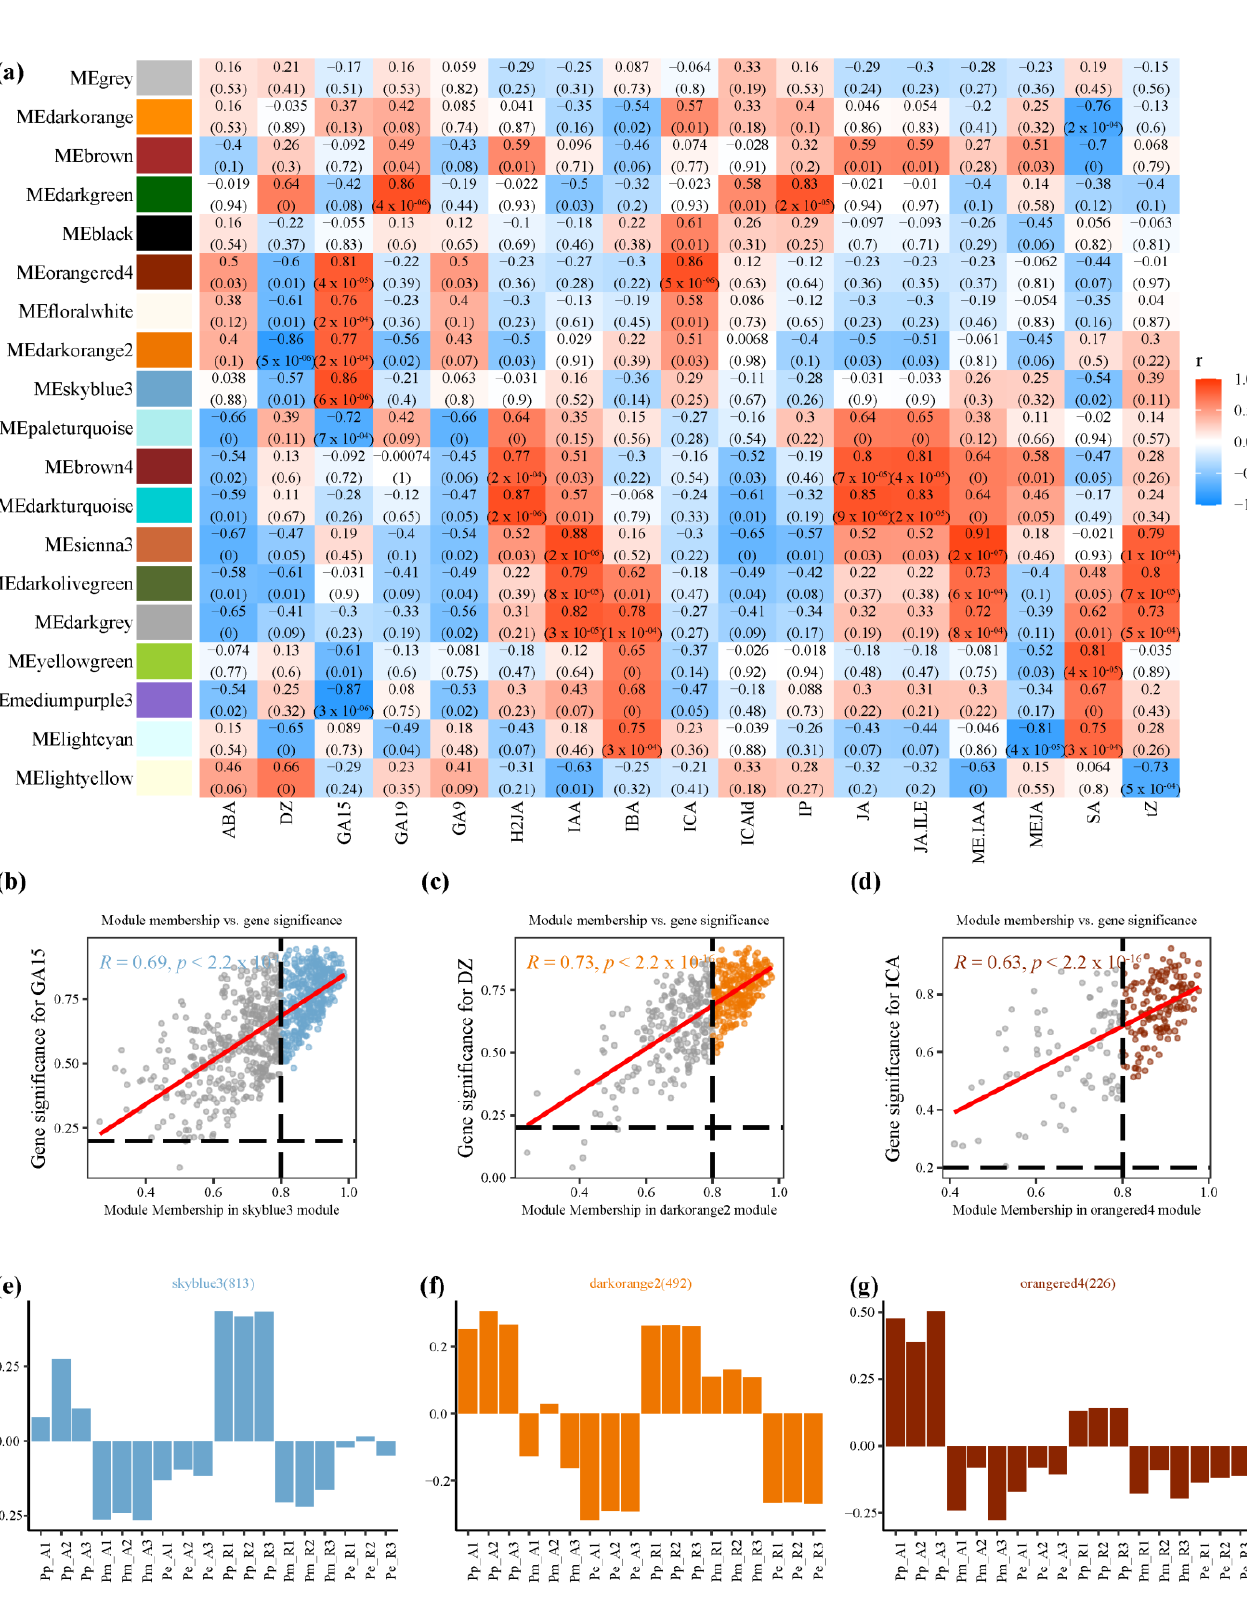
Figure 4. Weighted gene co-expression network analysis of the genes. ( a ) Correlated heatmap of the adjacency of modules; ( b ) a scatterplot of GS for GA 15 vs. MM in the skyblue3 module; ( c ) a scatterplot of GS for DZ vs. MM in the darkorange2 module; ( d ) a scatterplot of GS for ICA vs. MM in the orangered4 module; ( e ) the eigengene expression of skyblue3 module; ( f ) the eigengene expression of darkorange2 module; ( g ) the eigengene expression of orangered4 module. Note: In ( a ), each row